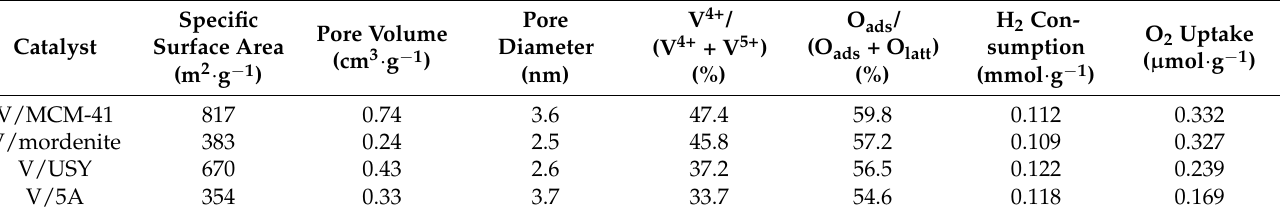
Table 1. Physicochemical parameters of the V/M catalysts.